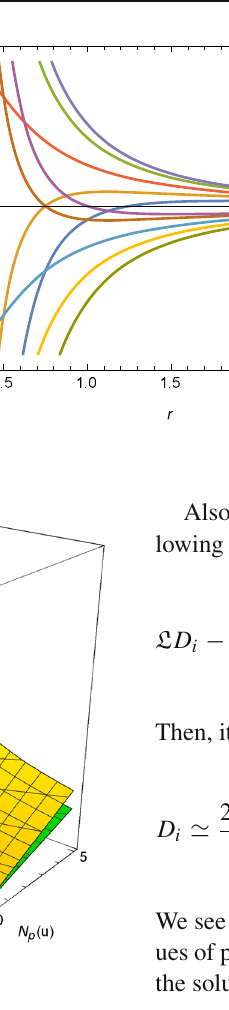
Fig. 8 The variation of D s sus typical values of the M ( u ) and N r ( u ) parameters for the radiation